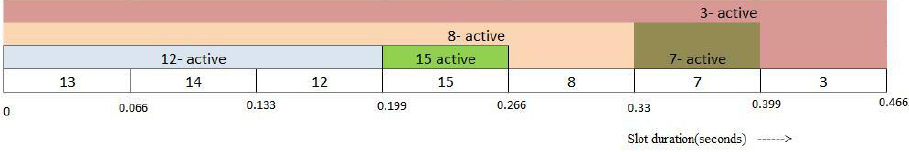
Figure 5. Slot allocation and parent node active state duration in conventional method.